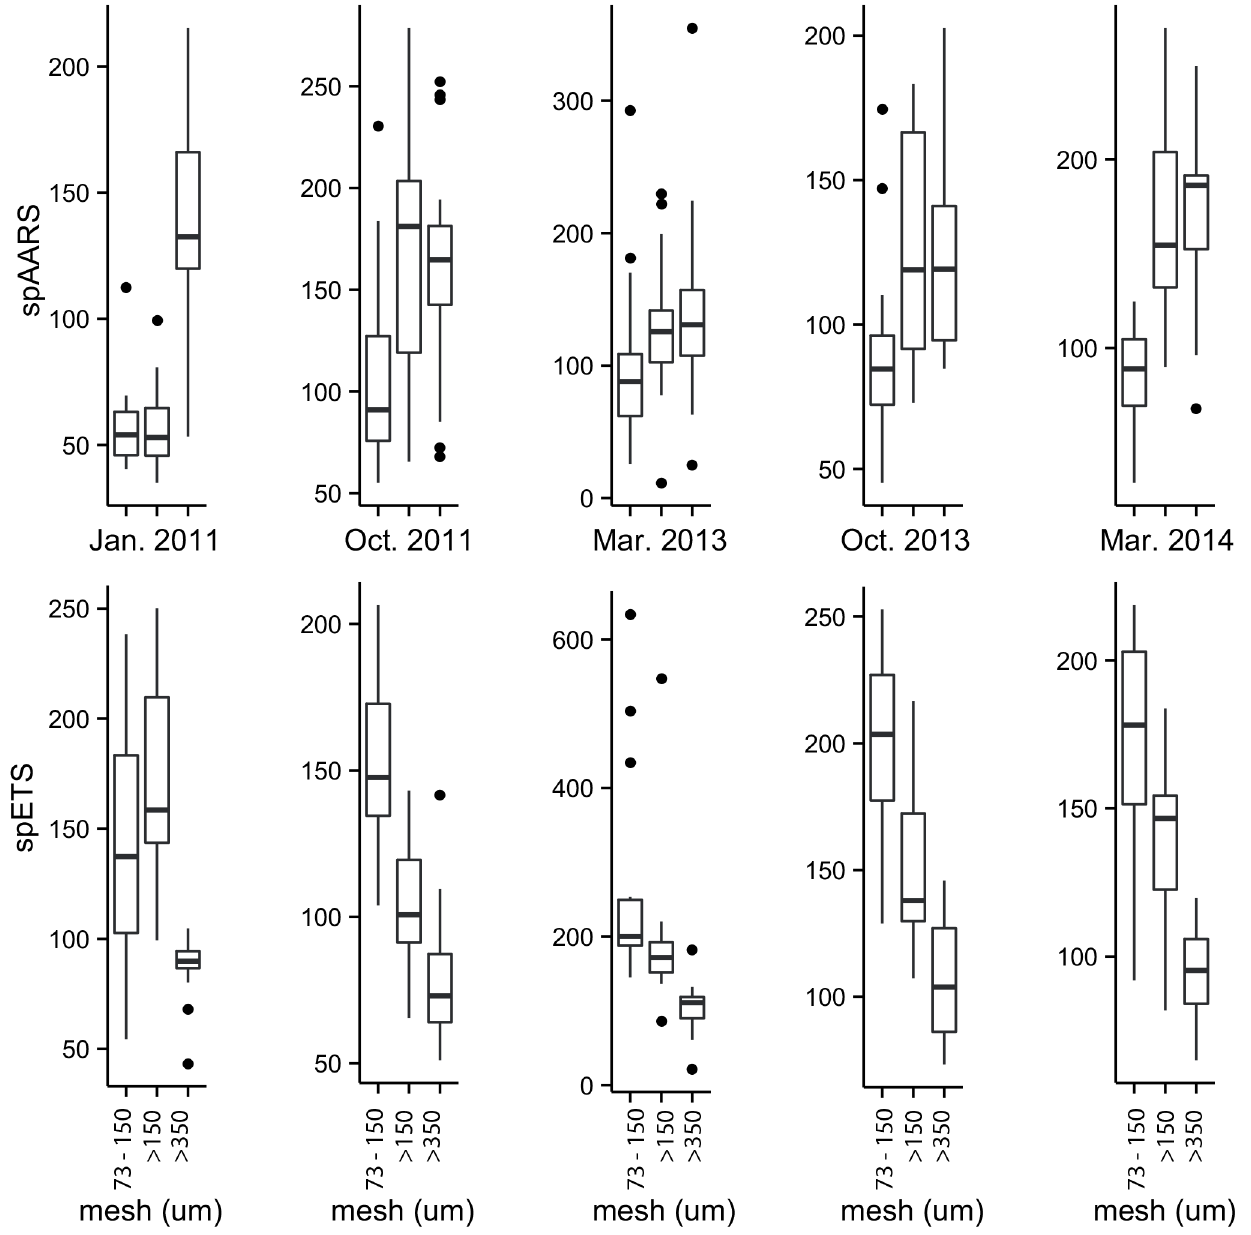
Fig 5. spAARS activity (nmol PPi hr -1 mg protein -1 ) and spETS activity ( μ L O 2 hr -1 mg protein -1 ) in 3 size fractions (73 – 150 μ m, > 150 μ m and > 350 μ m) of zooplankton samples collected from 5 cruises to the Kimberley coast, contrasting differences between size fractions.